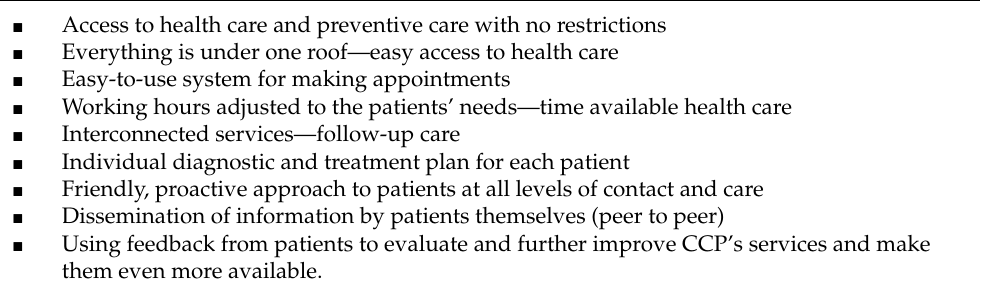
Table 1. Basic principles of the Comprehensive Care Program (CCP) for patients with addiction comorbidity [16].